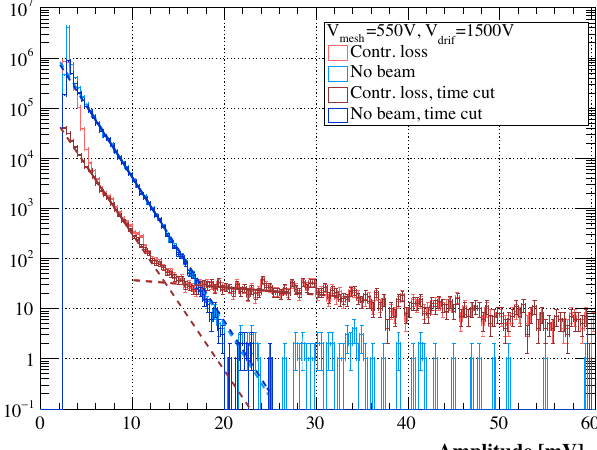
FIG. 11. Noise distributions extracted from raw data stream collected at different times and with the two voltage configura- tions used during the 2019 data-taking campaign. Noise RMS values are indicated in the legend.